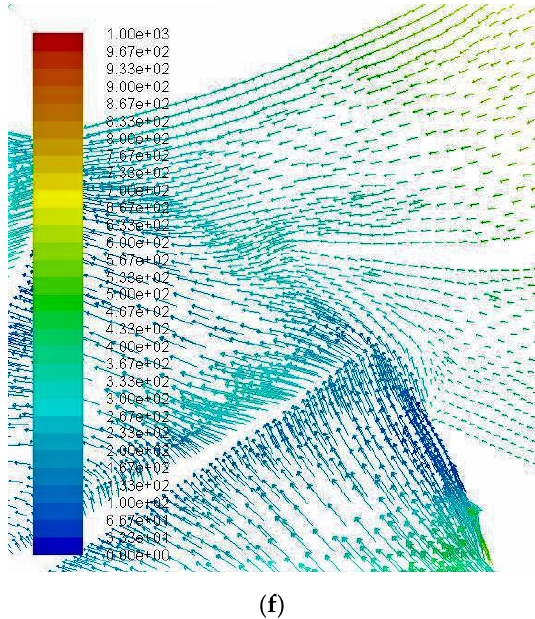
Figure 10. The plots of mass flow rate and total pressure monitored at the Section 1-1 of the exhaust pipes 1 and 2 for: ( a ) n = 40,000 rpm; ( b ) n = 50,000 rpm; ( c ) n = 60,000 rpm; and the corresponding velocity vectors at: ( d ) point A; ( e ) point B; ( f ) point C.